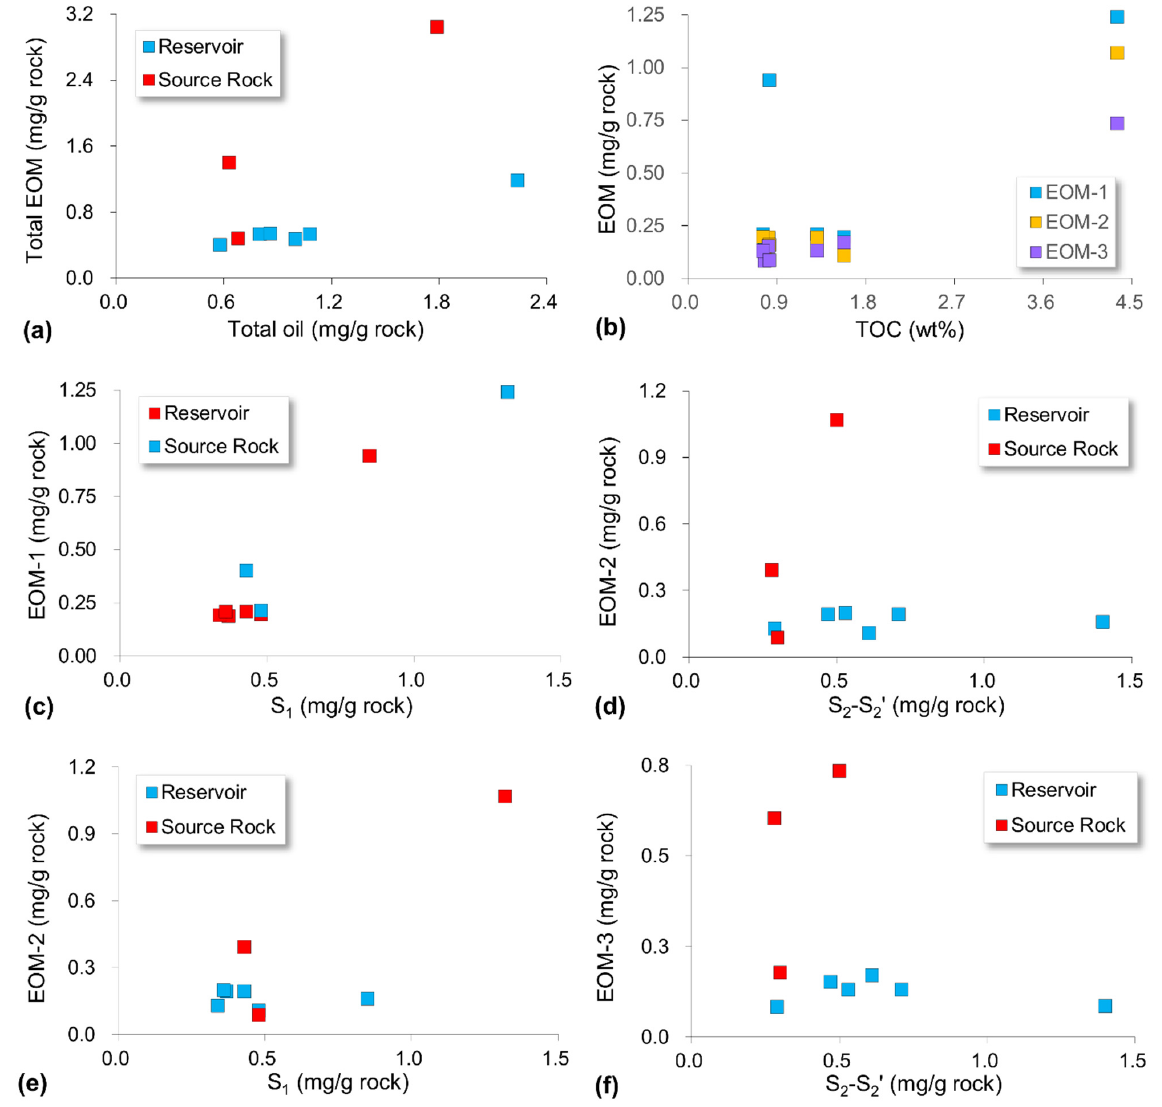
Figure 5. Correlation between solvent extraction yield and parameters derived from Rock-Eval pyrolysis: ( a ) total EOM vs. total oil yield; ( b ) sequential extraction yields vs. TOC content; ( c ) EOM-1 vs. S 1 ; ( d ) EOM-2 vs. S 2 –S 2 ′ ; ( e ) EOM-2 vs. S 1 ; ( f ) EOM-3 vs. S 2 –S 2 ′ .